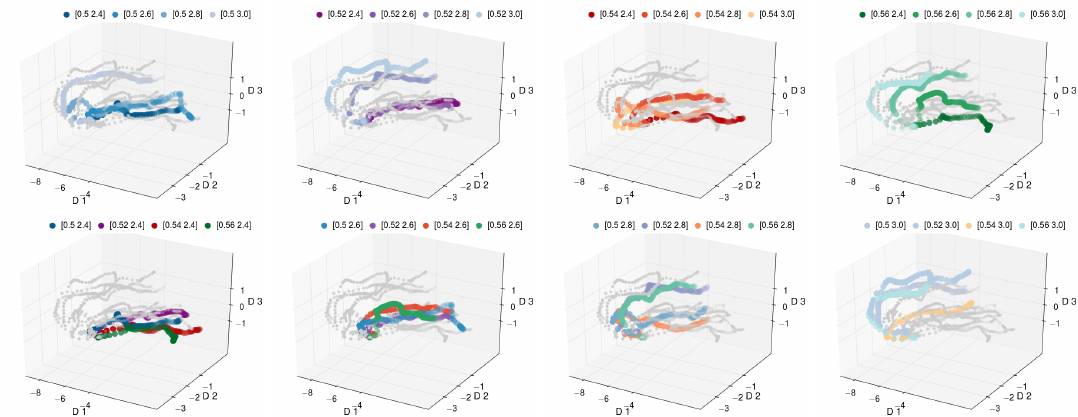
Figure 9. The manifold of the late stage with the first 80 points per trajectory. The same manifold is color coded according to increasing φ ( top ) and χ ( bottom ). (Please view in